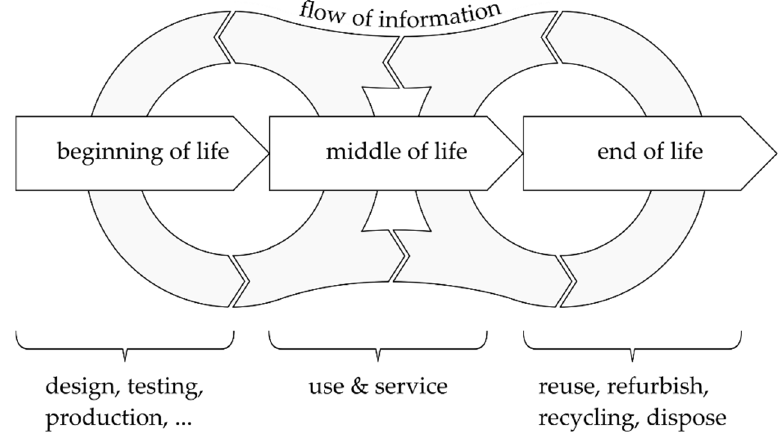
Figure 1. PLM model and its major information flows adapted from [24].